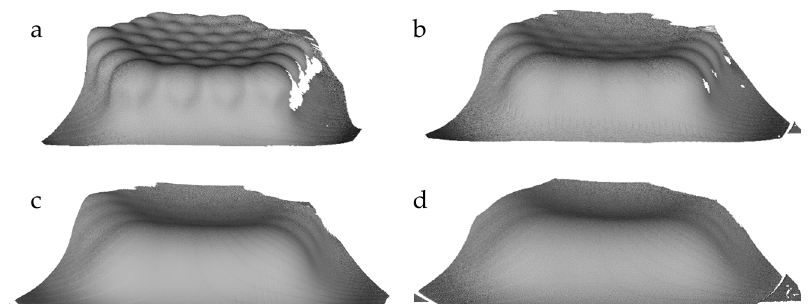
Figure 4. 3D scans of bowl shape created with a silicon rubber interpolation layer (40 Shore-A) with varying thickness (( a ) 5 mm, ( b ) 10 mm, ( c ) 15 mm and ( d ) 20 mm) at a vacuum of 100 hPa [23].